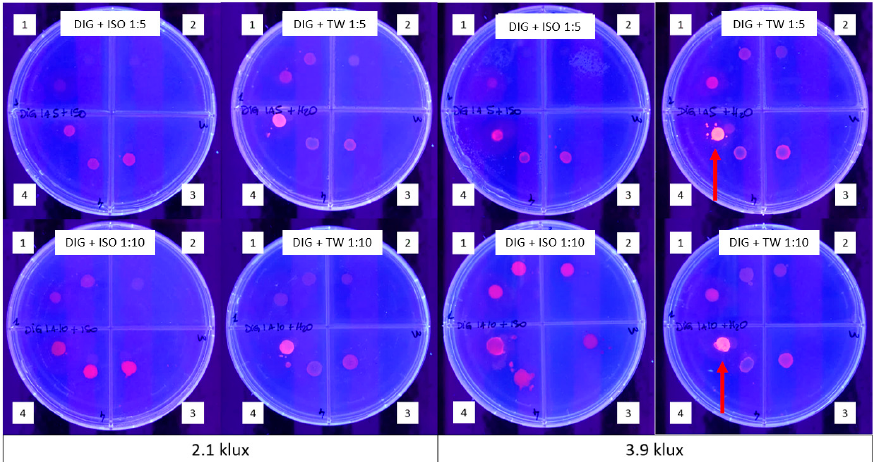
Figure 2. Nile red emissions after 20 min in the dark and with UV exposure of S. obliquus (1 and 2) and C. vulgaris (3 and 4) growth on Petri plate in control conditions (ISO and TW) and test conditions: DIG + ISO and DIG + TW 1:5 and 1:10. Microalgae growth was tested at two light irradiations, 2.10 klux and 3.9 klux. Arrows indicate fluorescent emission by colonies after Nile red coloring and ultraviolet